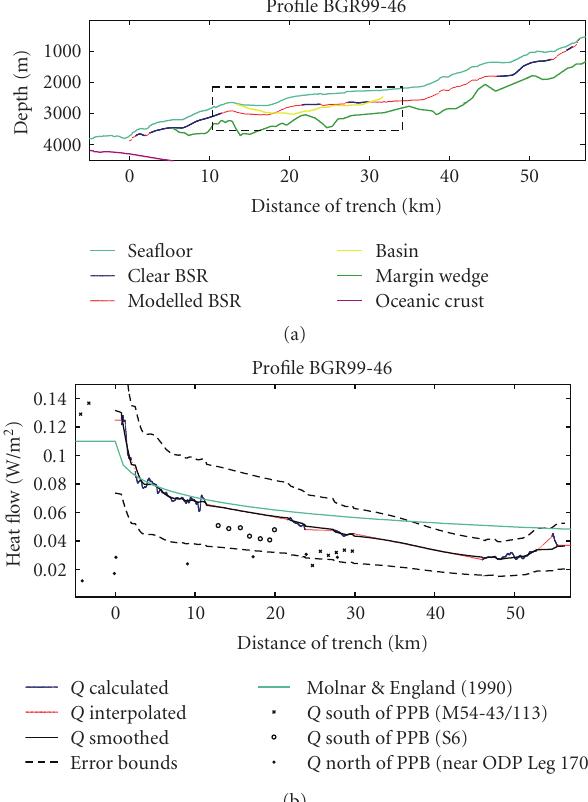
Figure 8: (a) The clear BSR (blue lines) is regularly distributed along the profile. After calculating its corresponding geothermal gradient and interpolating it, a modeled BSR (red lines) is derived. (b) The resulting smoothed heat flow trends with error bounds and an analytical heat flow curve from Molnar and England [51] are compared to in-situ data (Figure 3). The values north of the Paleo Plate Boundary near ODP Leg 170 and south of the plate boundary (S6) were derived from Langseth and Silver [18] and the values south of the plate boundary M54-43 and M54-113 were acquired by Grevemeyer et al.